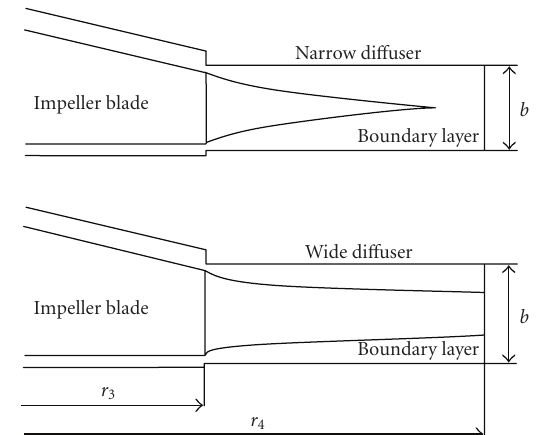
Figure 1: Flow in narrow di ff user and wide di ff